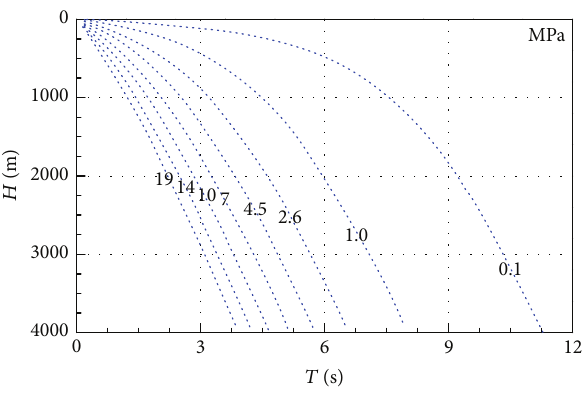
Figure 5: Pressure response time variations at different BP.